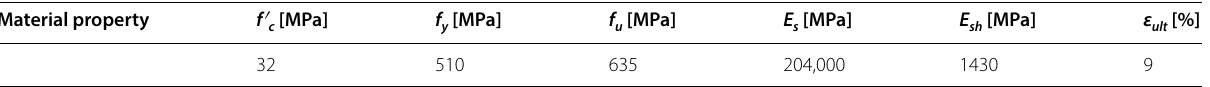
Table 1 Material parameters used in the simulation, obtained from material tests (see Tarquini et al. 2018). Material